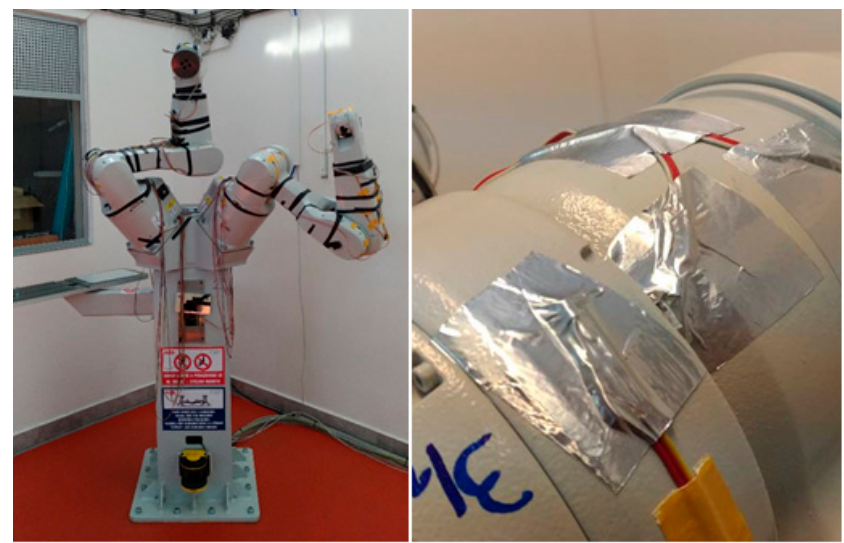
Figure 1. Thermal sensors, in detail on the second joint of the IRB1200 robot.